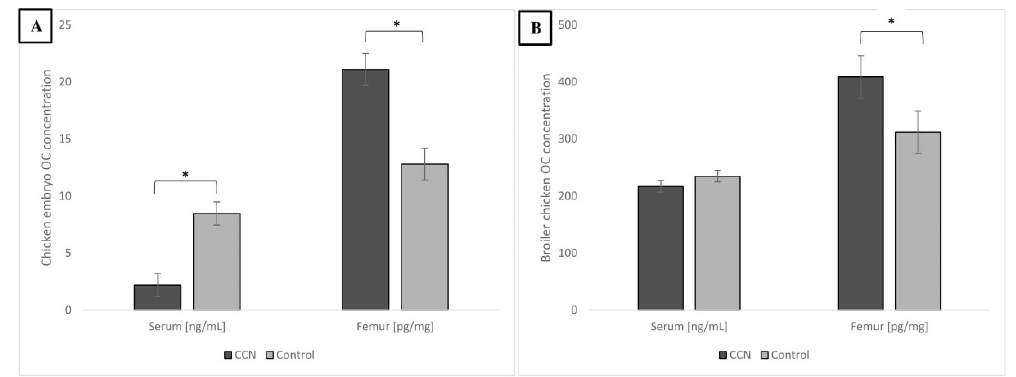
Figure 8. The OC concentration in serum and femoral bone from chicken embryo on 20 day after IOI with CNN ( A ) and from broiler chicken male after 42 d of rearing period ( B ). * Value on bars differs significantly at p ≤ 0.05. The error lines represent SEM.